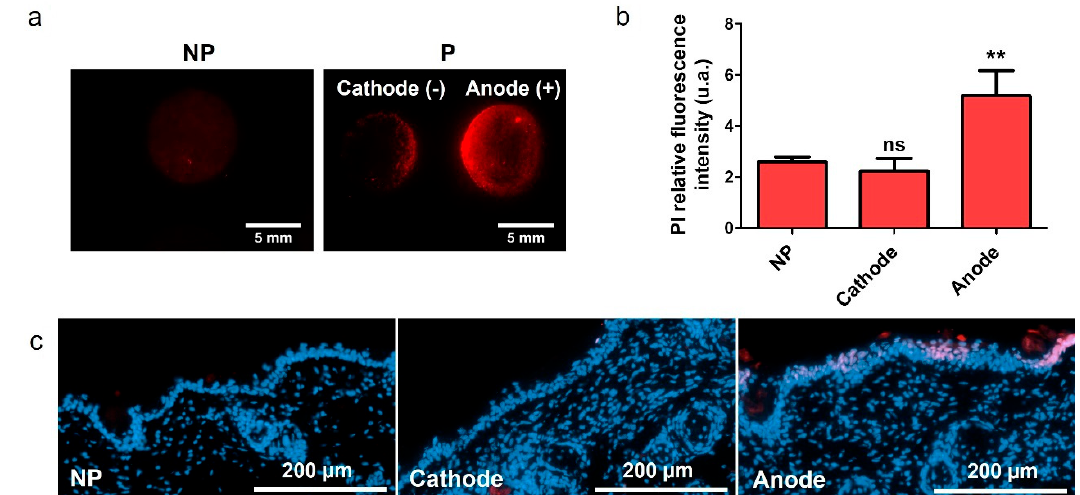
Figure 1. Evaluation of skin permeabilization using the two-in-one nanocomposite device for EP. Platforms loaded with PI (100 µM) were used to apply unipolar EP treatment on fresh hairless mice skin explants. Skins were imaged 30 min after. ( a ) Marking pattern of skins treated with unipolar-pulsed electric field, platforms loaded with PI. ( b ) Quantification of PI RFI at the cathode and anode of treated skins (P), compared to the PI RFI of non-pulsed (NP) skins. Statistical analysis: one-way ANOVA, with Dunnett’s post-test vs. NP. (Codes signification: ** = p > 0.01; ns = non-significant). n = 9. ( c ) Histological observations of 10 µm slices of skin treated with EP using platforms loaded with PI. PI is in red, and nuclei are labelled in blue by DAPI.